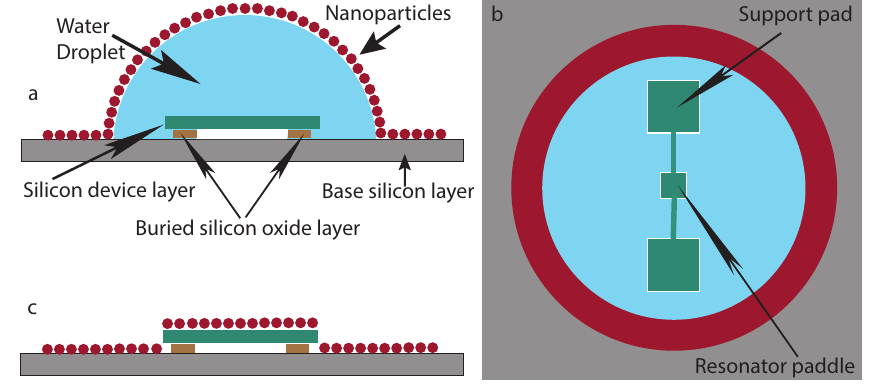
Figure 2. Schematic of self-assembly of nanoparticles (not to scale). ( a ) Side view schematic of nanoparticle deposition. Gray color represents the base silicon (700 µ m thick), brown color is the silicon oxide layer (1 µ m thick), and green color is the top silicon layer used as the device layer (300 nm thick). Water is displayed in blue while the nanoparticles are represented in red. ( b ) Top view of the schematic. The nanoparticles actually cover the water droplet and the device but are omitted in part of this view to show the device shape. ( c ) Side view of the device and nanoparticles after the drying